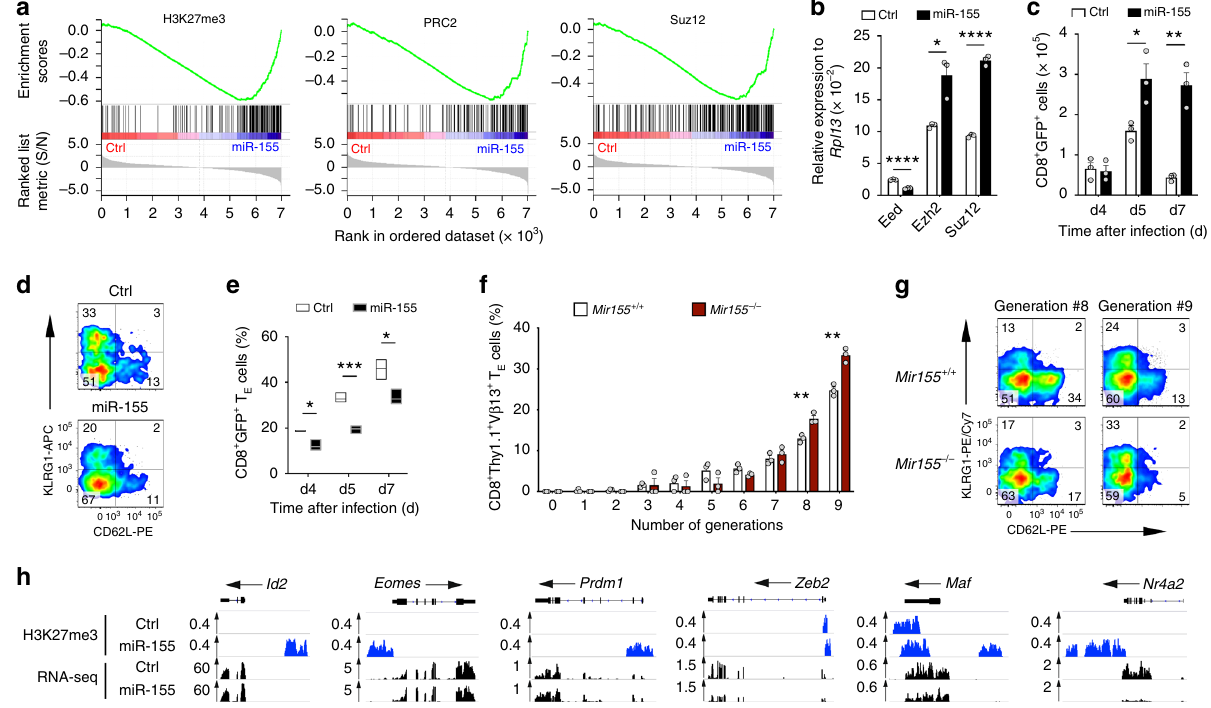
Fig. 1 miR-155 epigenetically silences CD8 + T cell differentiation. a Negative enrichment of H3K27me3 genes 20 (left) and PRC2 (middle) and Suz12 (right) targets 21 in miR-155-overexpressing cells. b Quantitative RT-PCR of Eed, Ezh2 , and Suz12 mRNA in miR-155 and Ctrl-overexpressing cells sorted 5 days following adoptive transfer of 3 × 10 5 pmel-1 CD8 + T cells transduced with miR-155 or Ctrl-miR into wild-type mice in conjunction with gp100-VV. Bars (mean ± s.e.m. of technical triplicates) are relative to Rpl13 mRNA. c Number of splenic pmel-1 CD8 + GFP + T cells assessed at different time points after transfer as in b . d Flow cytometry of splenic pmel-1 CD8 + GFP + T cells 5 days after transfer as in b . Numbers indicate the percentage of cells after gating